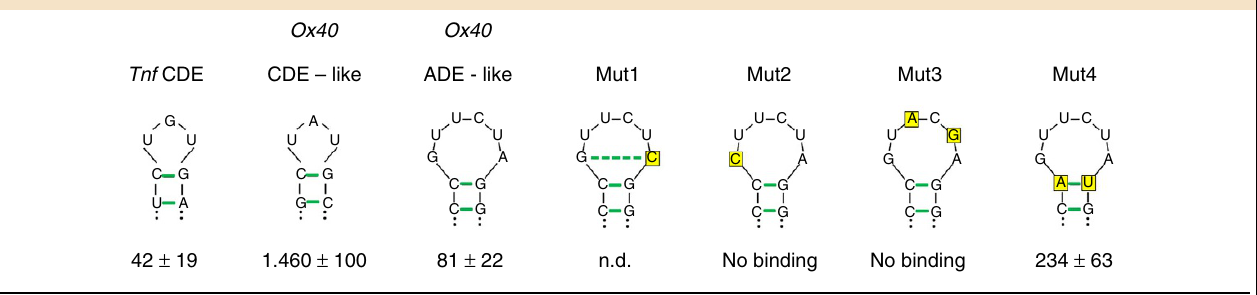
Table 2 | K D for selected RNAs obtained from SPR measurements with immobilized ROQ domain of